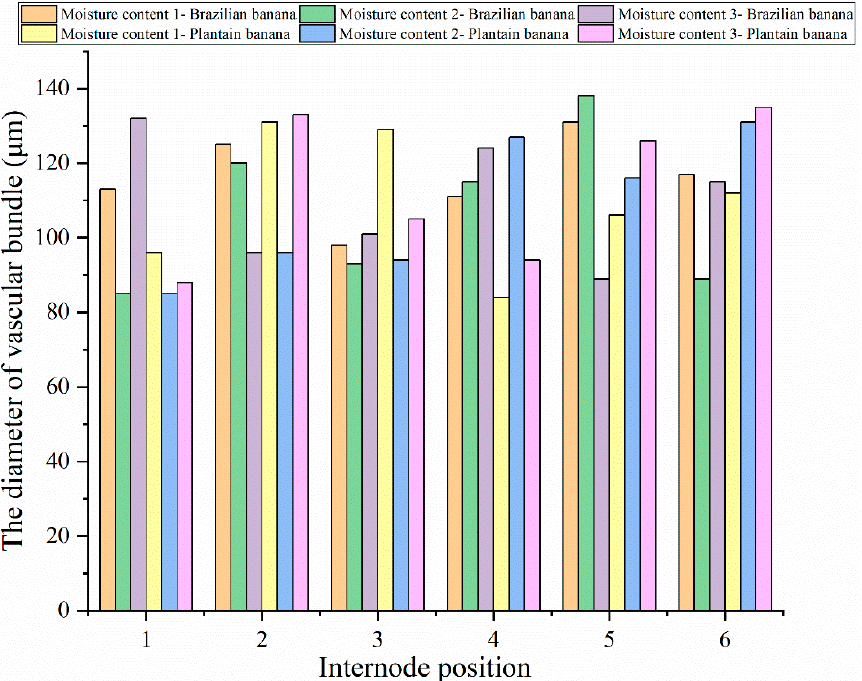
Figure 14. The relationship between the diameter of the vascular bundle and the internode positions.